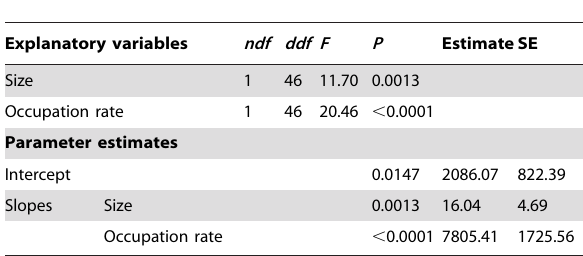
Table 1. Results of ANCOVA testing for the effects of plant size, plant type (PA, PnoA and NoP) and their interaction on total leaf area.